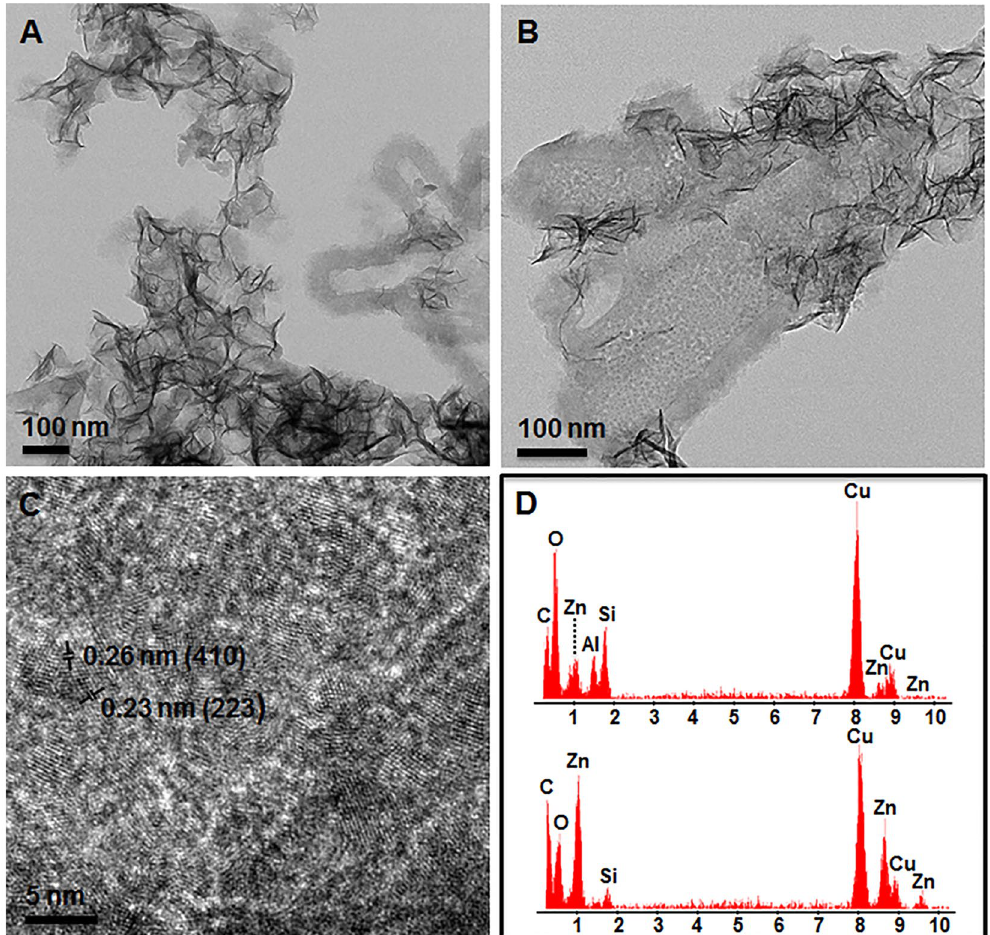
Figure 3. TEM images and energy dispersive X-ray spectra (EDS) of air-dried whole mount synthesized sauconite with 1.0 M succinate at pH 0 9.0 after 6 h reflux at 90 °C. ( A ) Aggregates of sauconite nanocrystals. Gel-like material shows nucleation of sauconite (right side of image). ( B ) Higher magnification of the gel-like sauconite showing the presence of unknown zinc-containing nanocrystals in addition to sauconite. ( C ) Lattice fringe image of zinc nanoparticles. ( D ) Representative EDS spectra of the composition of sauconite nanocrystals (upper) and zinc nanoparticles (lower). The presence of Cu is due to the carbon coated copper grid used for EDS